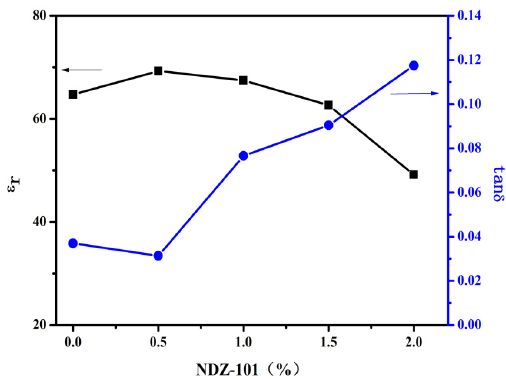
Figure 4. Effects of NDZ ‐ 101 on the dielectric properties of PZT ‐ PVDF.